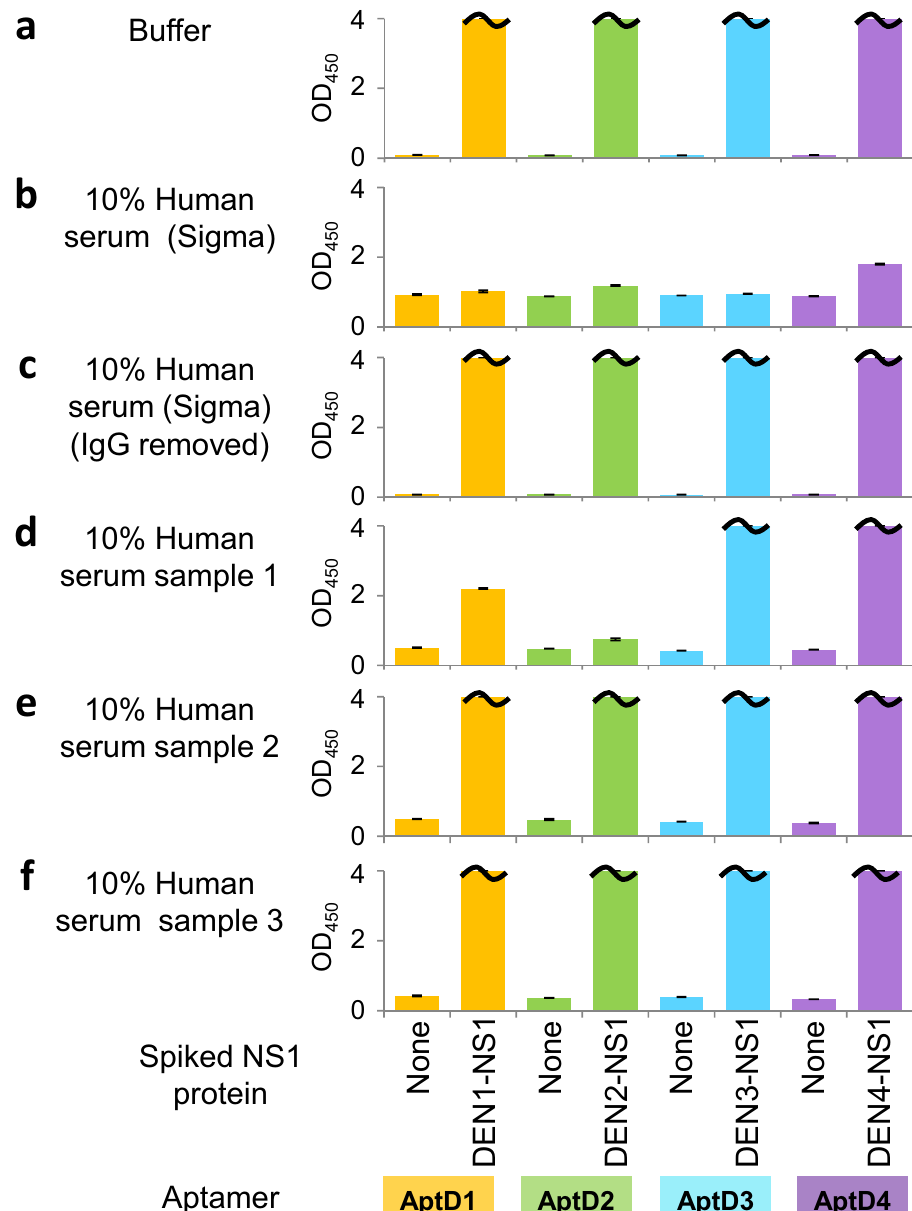
Figure 3. Inhibitory effects of human serum against direct NS1 detection. Inhibitory effects of different human serum samples were analyzed using the aptamer/antibody (Apt/Ab) ELISA format. Each UB-DNA aptamer was employed as the capture agent, and the antibody, Ab#D06, was used as the primary detector agent. Each serotype DEN-NS1 was added in buffer (a) or human serum purchased from Sigma (untreated in b or treated with protein A resin for removal of IgGs in c ), or each human serum sample obtained from three different persons with no current dengue infection (d–f) . The mixtures were subjected to ELISA at the final 10% human serum concentration. A certain amount of the recombinant DEN-NS1 purchased from The Native Antigen Company (350 pg for DEN1-NS1, 350 pg for DEN2-NS1, 450 pg for DEN3-NS1, and 200 pg for DEN4-NS1) was added in each well (50